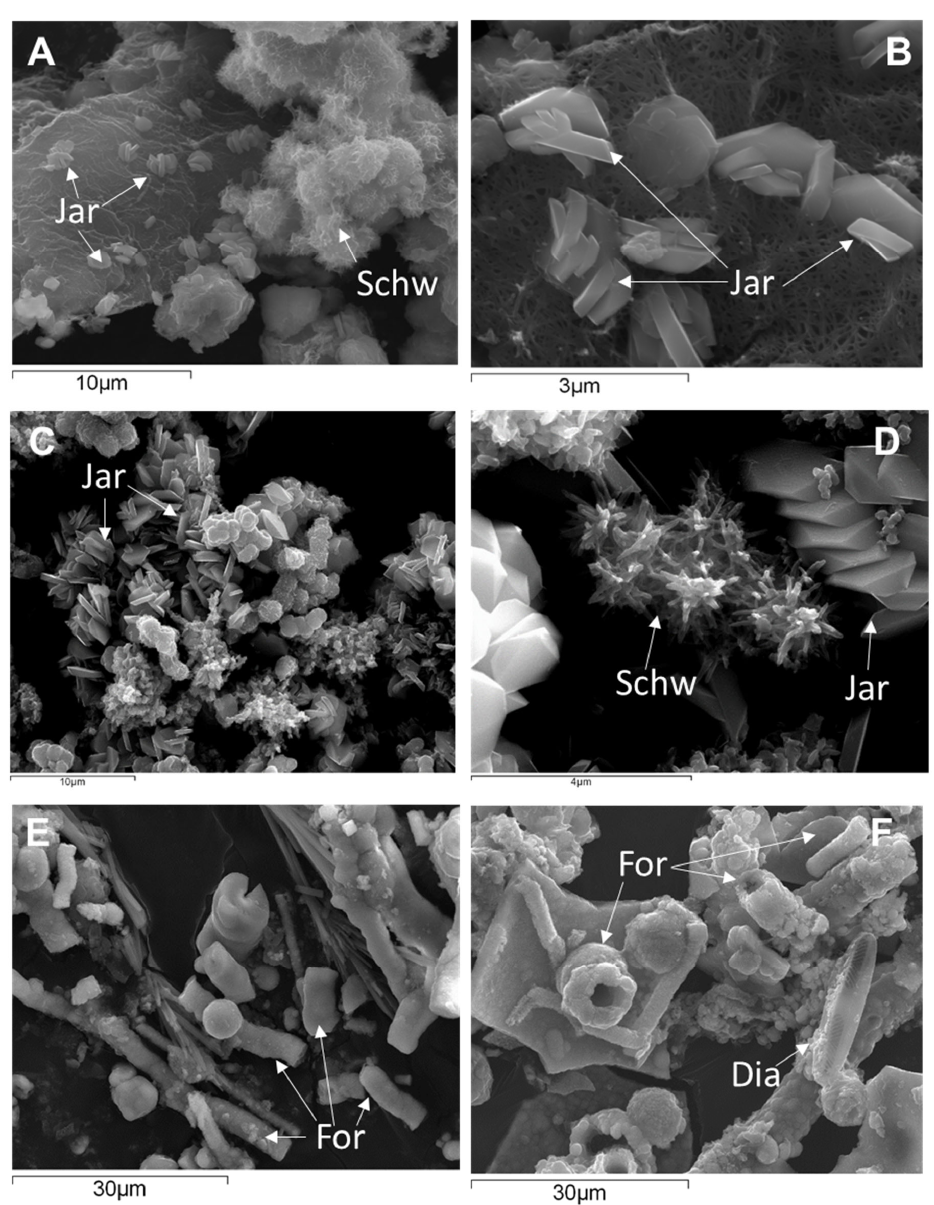
Figure 7. SEM pictures obtained from floating mineral films formed in lab experiments with originally anoxic waters from the Tintillo acidic stream ( A , B , E , F ) and Guadiana acidic pit lake ( C , D ). ( A , D ) show schwertmannite (Schw) with characteristic pin-cushion or hedgehog texture and formed at pH~3.0 coexisting with euhedral crystals of jarosite (Jar) formed at pH~2.2. ( E , F ) show abundant fossilized organic remnants (For) and sparse diatoms (Dia) in the sample from the Tintillo stream.